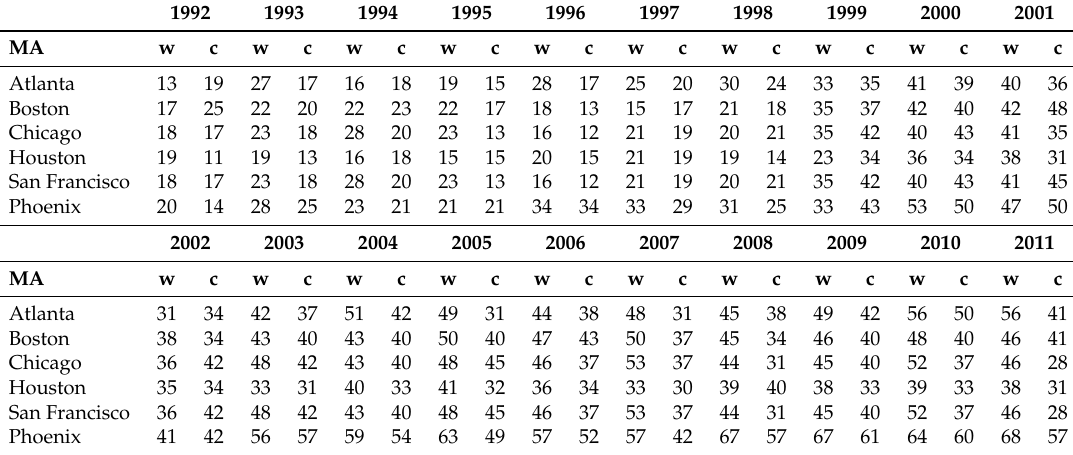
Table 1. Number of Landsat images available in the Climate Engine (CE) platform for each of the investigated U.S. MA, respectively in the warm (w) period (March, April, May, June, July, August) and cold (c) period (September, October, November, December, January, February). The orbits of Landsat satellites are solar synchronous, and passages are between 10:00 and 10:30 mean local time at the Equator, in order to provide maximum illumination with minimum water vapor (haze and cloud build-up)